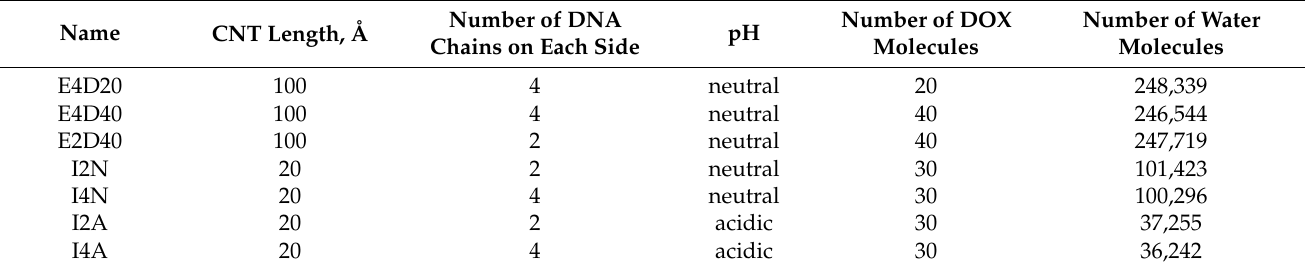
Table 1. Parameters of the analyzed